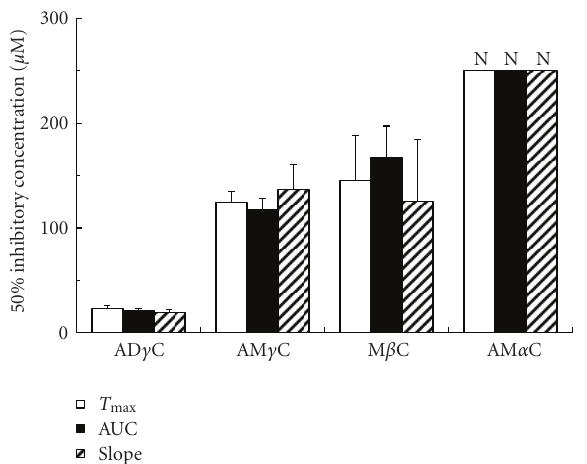
Figure 5: Concentrations of carbolines to produce 50% inhibition of the second phase platelet aggregation responses ( T max , AUC, and slope) to epinephrine. N: Not inhibited by 50% at the indicated concentrations. Data are presented as mean ± SE ( n = 7).